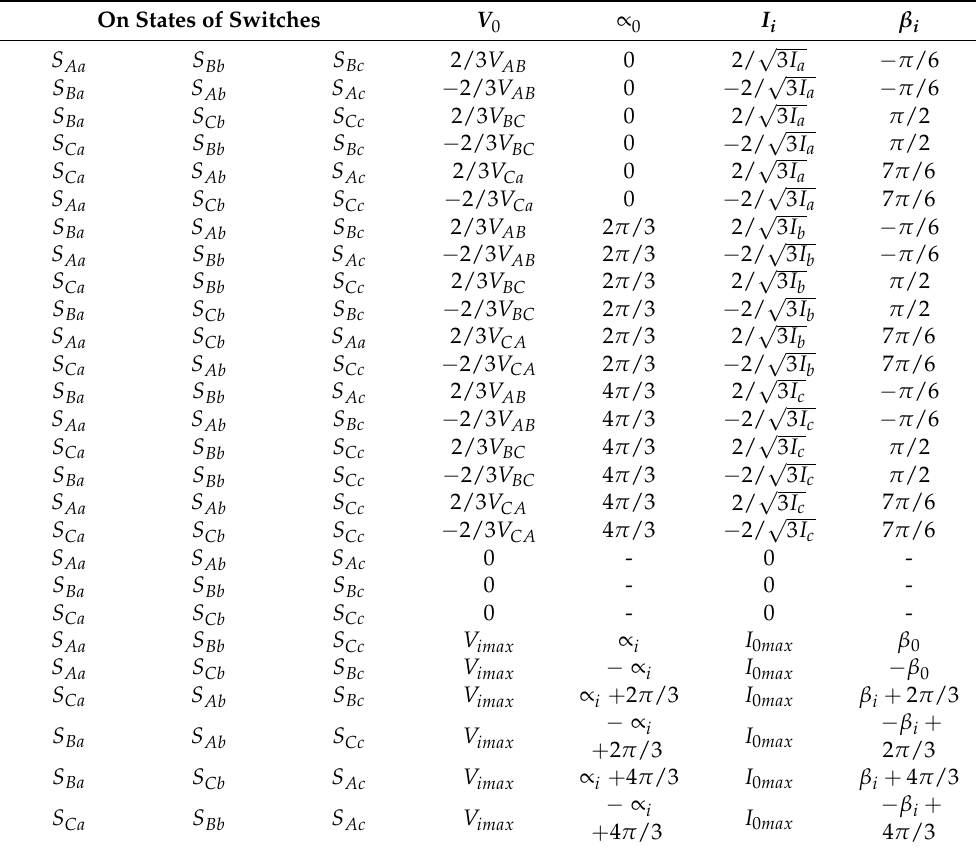
Table 1. States of switches and their respective input and